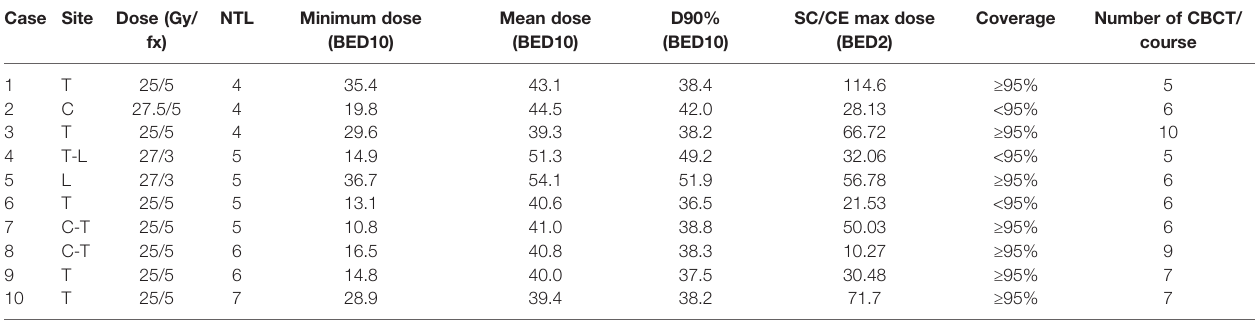
TABLE 4 | Plan and treatment delivery characteristics for patients with 4 – 7 contiguous treated levels. Case Site Dose (Gy/